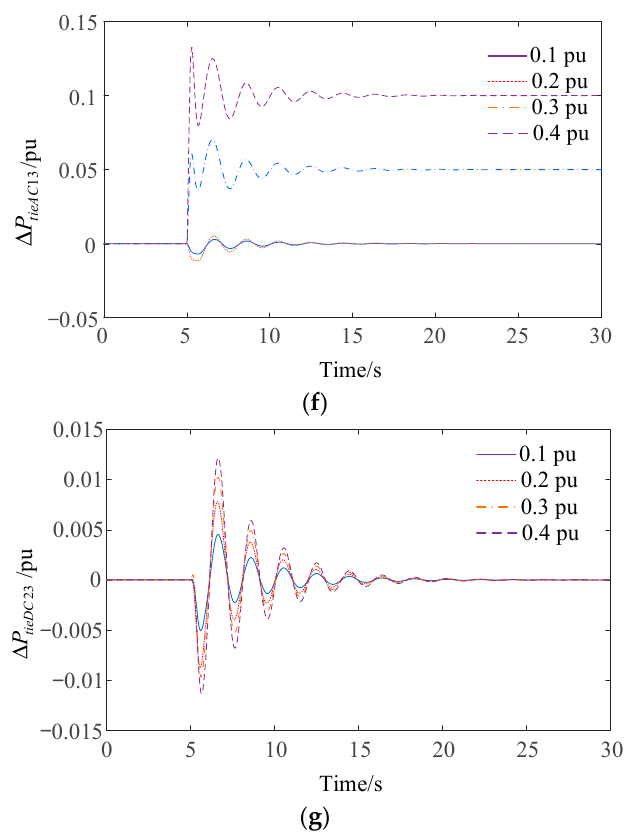
Figure 7. Dynamic time domain responses of three-area system under different load stepping disturbances: ( a ) frequency deviation of Area 1; ( b ) frequency deviation of Area 2; ( c ) frequency deviation of Area 3; ( d ) power deviation of AC tie-line 12; ( e ) power deviation of DC tie-line 12; ( f ) power deviation of AC tie-line 13; ( g ) power deviation of AC tie-line 23.